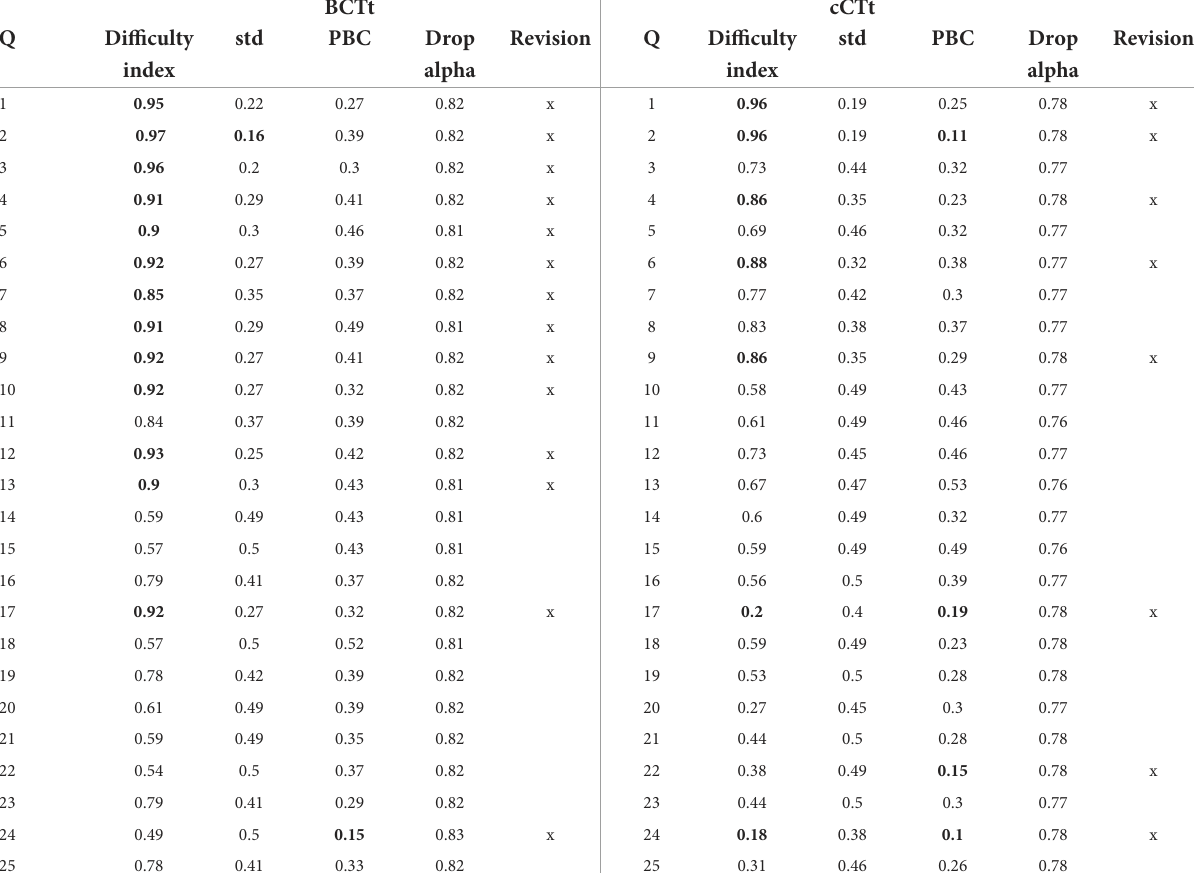
TABLE 4 Full BCTt (Cronbach’s α BCTt = 0.82) and cCTt (Cronbach’s α cCTt = 0.78) Classical Test Theory